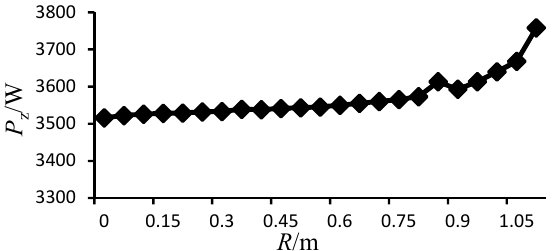
Figure 10. Relative oscillating amplitude through varying tip radius of cone.